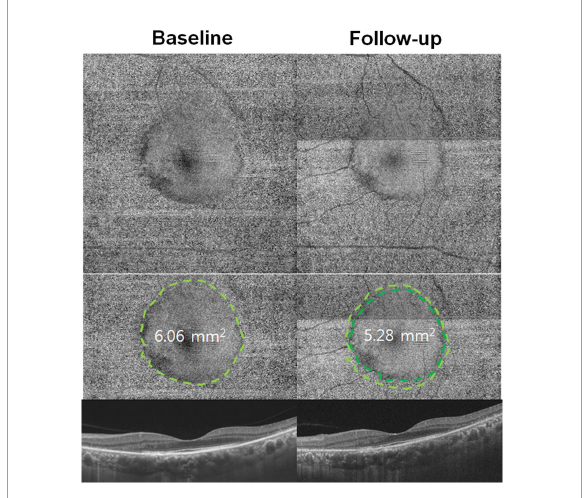
FIGURE2 En face optical coherence tomography (OCT) imaging in hydroxychloroquine retinopathy. En face OCT images demonstrate a smooth surface in the central area (inside the dashed line) on the areas with intact photoreceptors, whereas, the more granular reflectivity (outside the line) is noted in the pericentral area with retinal degenerative changes. The area with intact photoreceptors can be calculated and used as a quantitative measure of photoreceptor damage. Progression of photoreceptor damage is represented as a constricted ring at follow-up (10 months later). The quantitative measure, area with intact photoreceptors, decreases from 6.06 at baseline